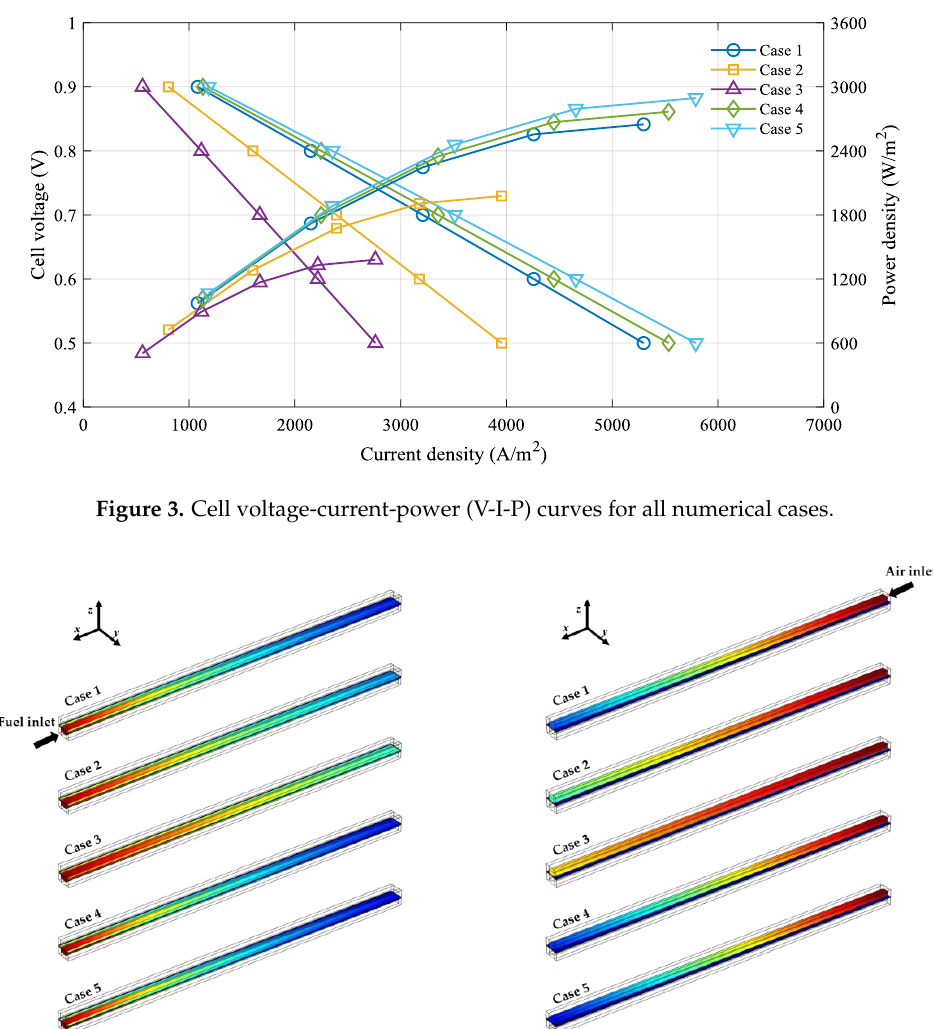
Figure 6. Three-dimensional temperature distribution on an entire unit cell stack in the reference case (case 1) having an electrolyte thickness of 100 μm and an operating temperature of 800 °C. ( a ) ( b ) Figure 7. Temperature profile along the fuel channel: ( a ) at an operating voltage of 0.9 V and ( b ) with different operating voltages from 0.5 to 0.9 V for case 1 having an electrolyte thickness of 100 μm and an operating temperature of 800 °C. 5. Conclusions A numerical simulation of a three-dimensional unit cell stack was conducted to investigate the effect of electrolyte thickness and operating temperature on SOFC performance. We studied unit cell stacks, but the effect from one channel to another was also considered through periodic boundary conditions. We should fully understand how the reactions and heat transfer characteristics inside